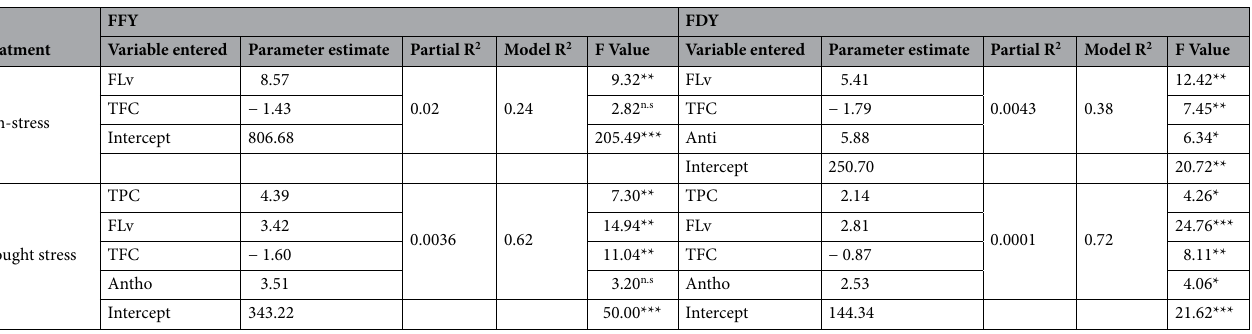
Table 5. Results of stepwise regression analysis for predicting fresh and dry forage yield contributors in Poa pratensis accessions evaluated in non-stress and drought stress conditions. n.s, *, ** and *** represent non- significant, significant at P < 0.05, P < 0.01 and P < 0.001, respectively. TPC, total phenol content; TFC, total flavonoid content; FLv, flavanone; Anti, antioxidant activity; Antho, anthocyanin; FFY, forage fresh yield; FDY, forage dry weight.